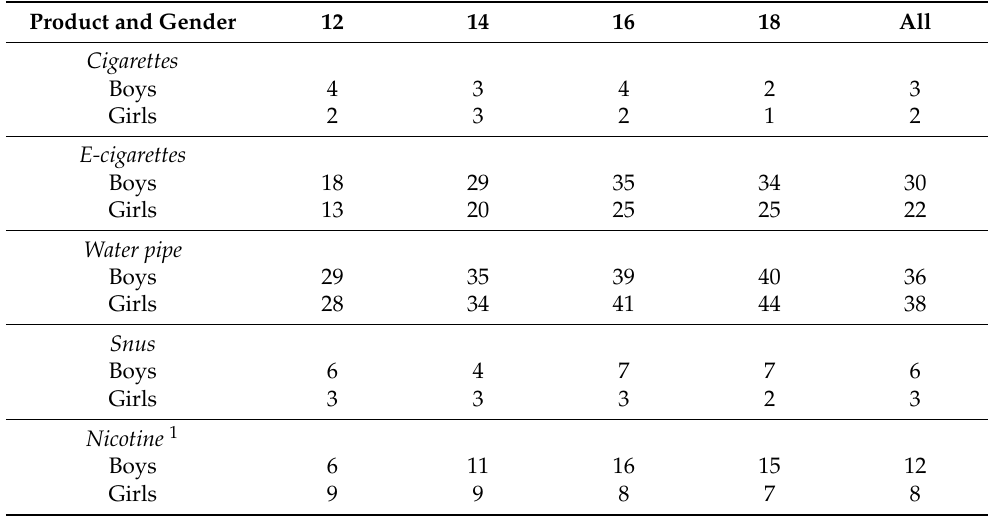
Table 2. Percentage (%) of adolescents who reported that cigarettes, e-cigarettes, water pipe, snus, and nicotine 1 are not harmful to health, by age and